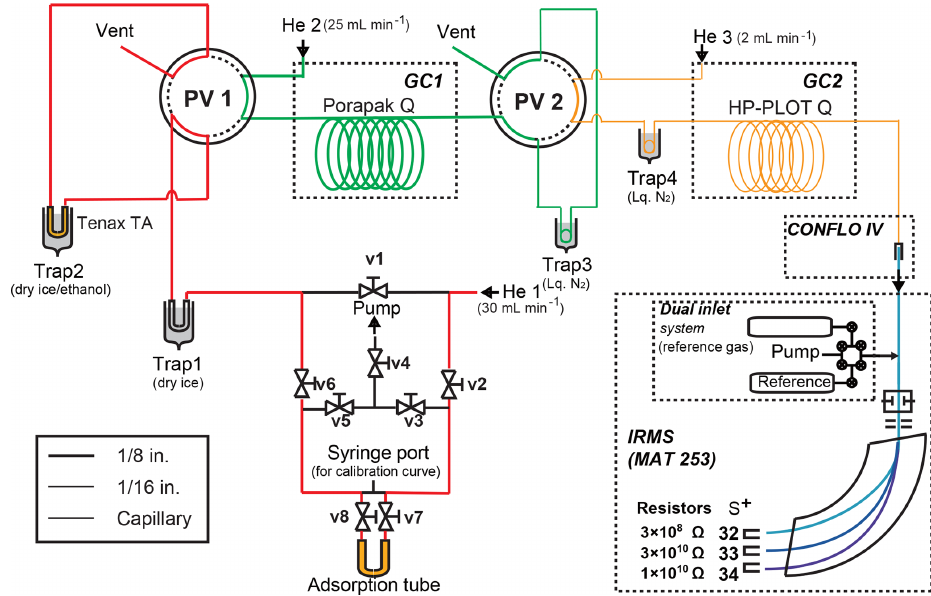
Figure 2. Schematic diagram of the OCS purification system. System components: V, valve; pump, vacuum pump; MFC, mass flow con-